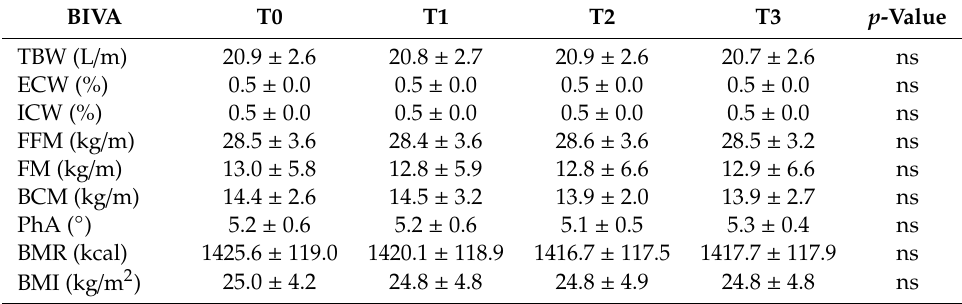
Table 4. Biolectrical Impedance Vector Analysis (BIVA) parameters and BMI. TBW: Total Body Water, ECW: Extracellular Water, ICW: Intracellular Water, FFM: Fat-Free Mass, FM: Fat Mass, BCM: